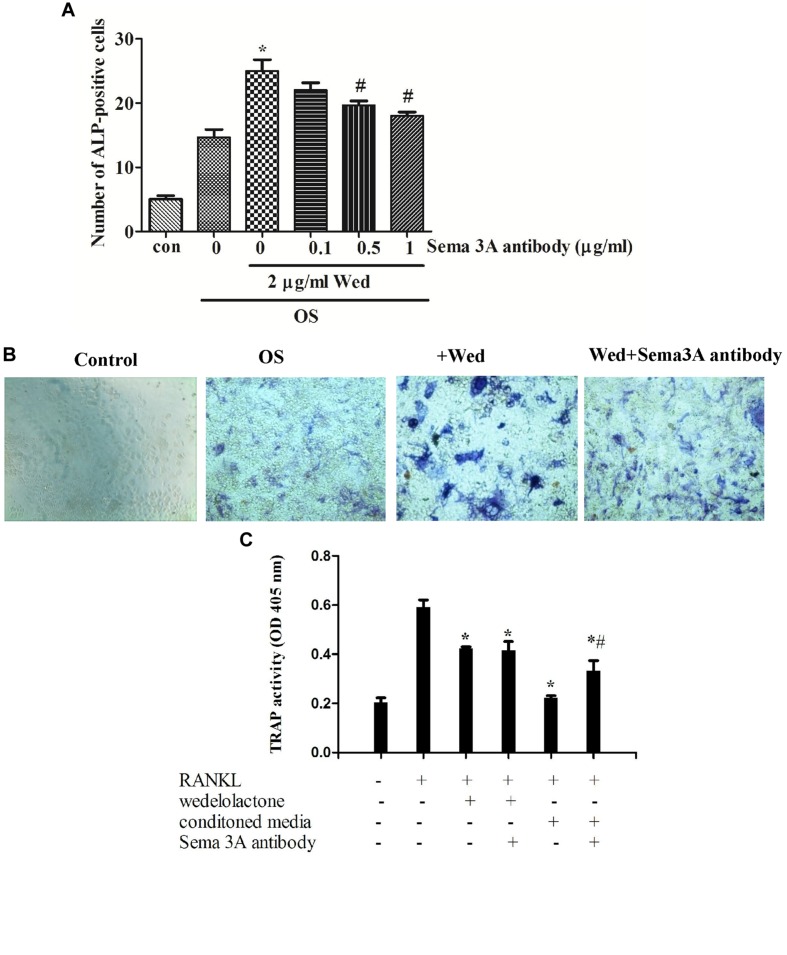
Effects of Sema3A antibody on wedelolactone-induced ALP activity in BMSC and TRAP activity in RAW264.7 cells. (A) BMSC were cultured in OS medium containing 2 μg/ml wedelolactone and Sema3A antibody for 9 days. The cells were fixed and stained for ALP activity. The data represent the mean ± SEM (n = 3). (B) ALP staining for BMSC. The cells were treated with conditions as follows: (a) control; (b) OS; (c) OS+wedelolactone; (d) OS+wedelolactone + Sema3A antibody for 4 days. Cells were then stained for ALP by using a ALP staining kit and imaged at 200×. (C) TRAP activity in RAW264.7 cells were assayed after the cells were treated with conditioned media for 9-day fraction or Sema3A antibody for 4 days. The data represent the mean ± SEM (n = 3). ∗P < 0.05 compared with RANKL-treated cells. #P < 0.05 compared with conditioned media-treated cells.